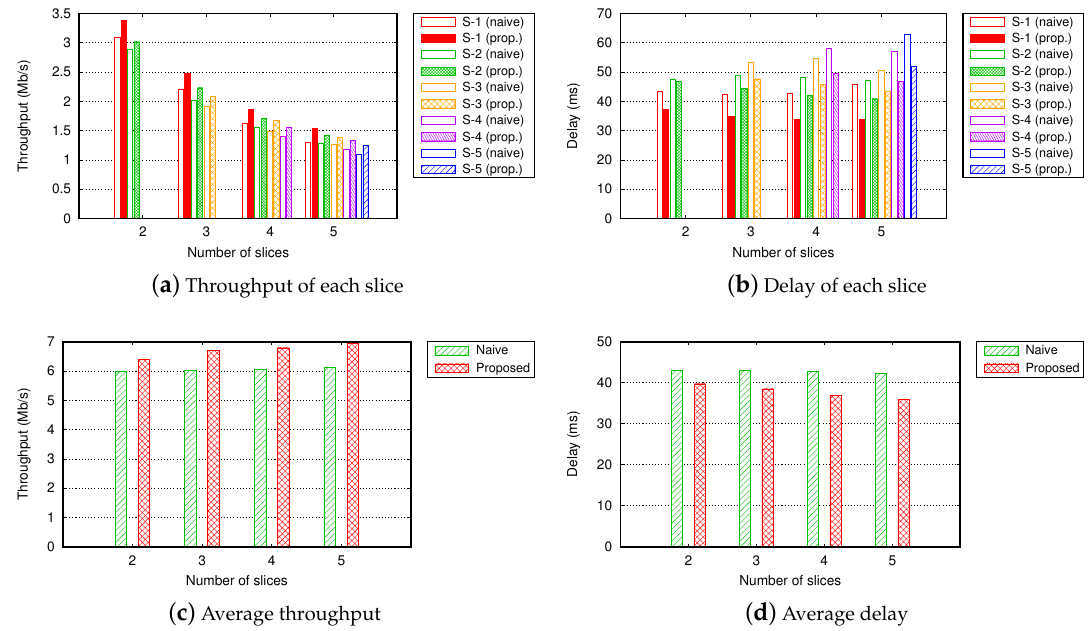
Figure 7. Throughput and delay across different numbers of slices in a grid topology (number of total flows = 30, Γ = ∞ ).